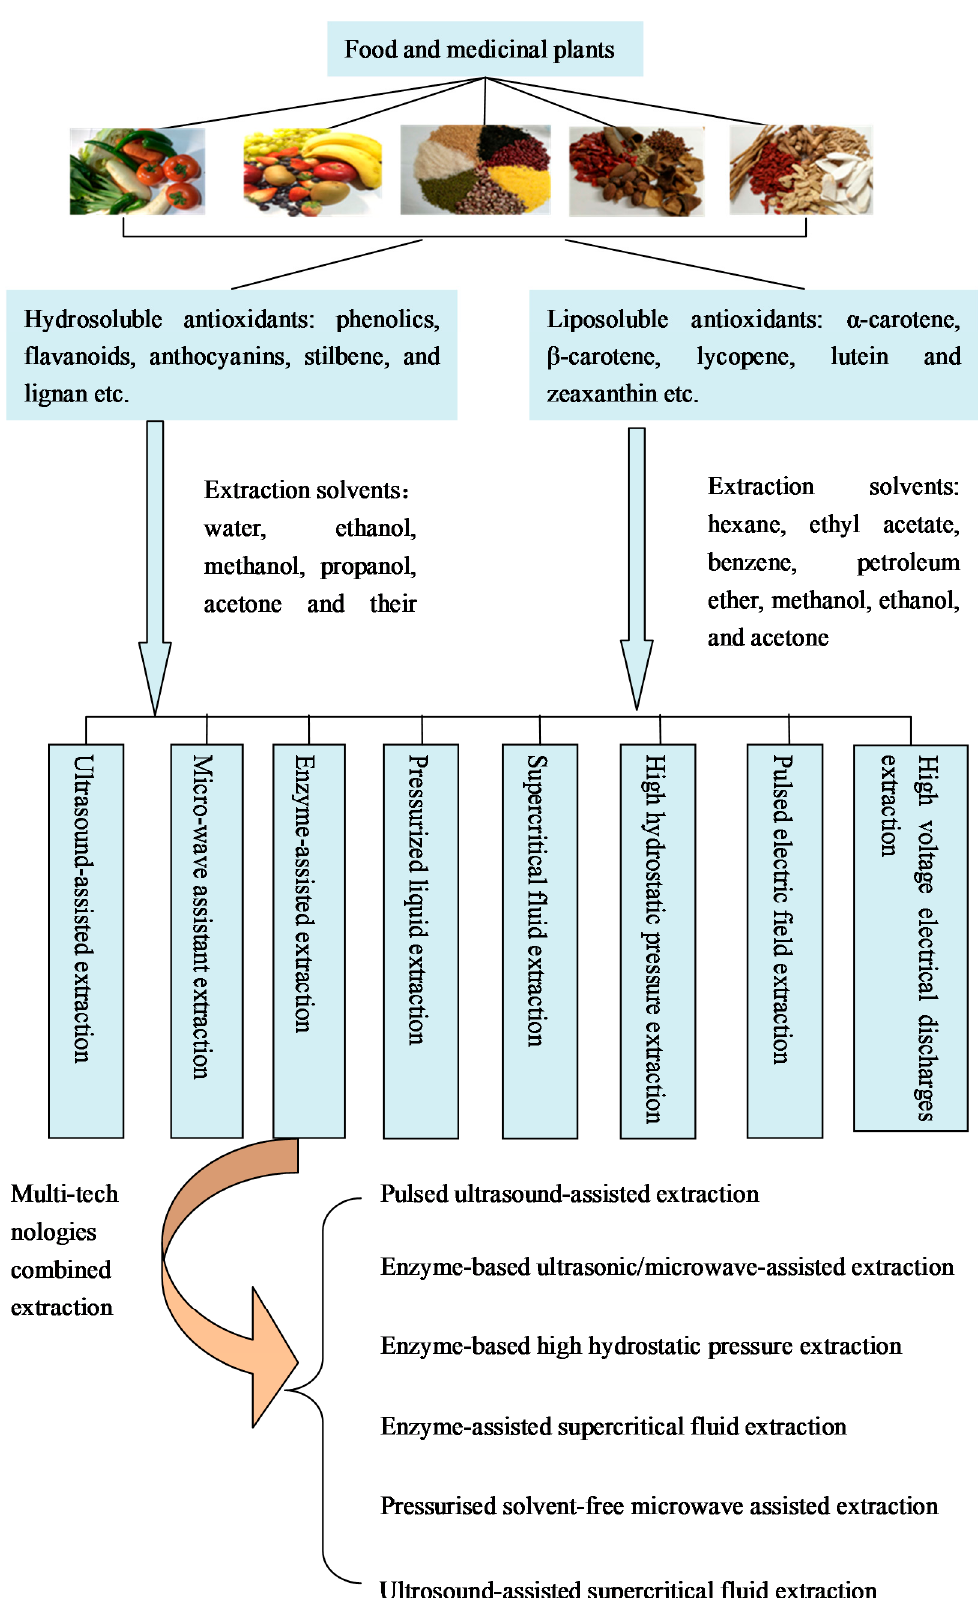
Figure 1. The outline of extraction of antioxidants from foods and medicinal plants.